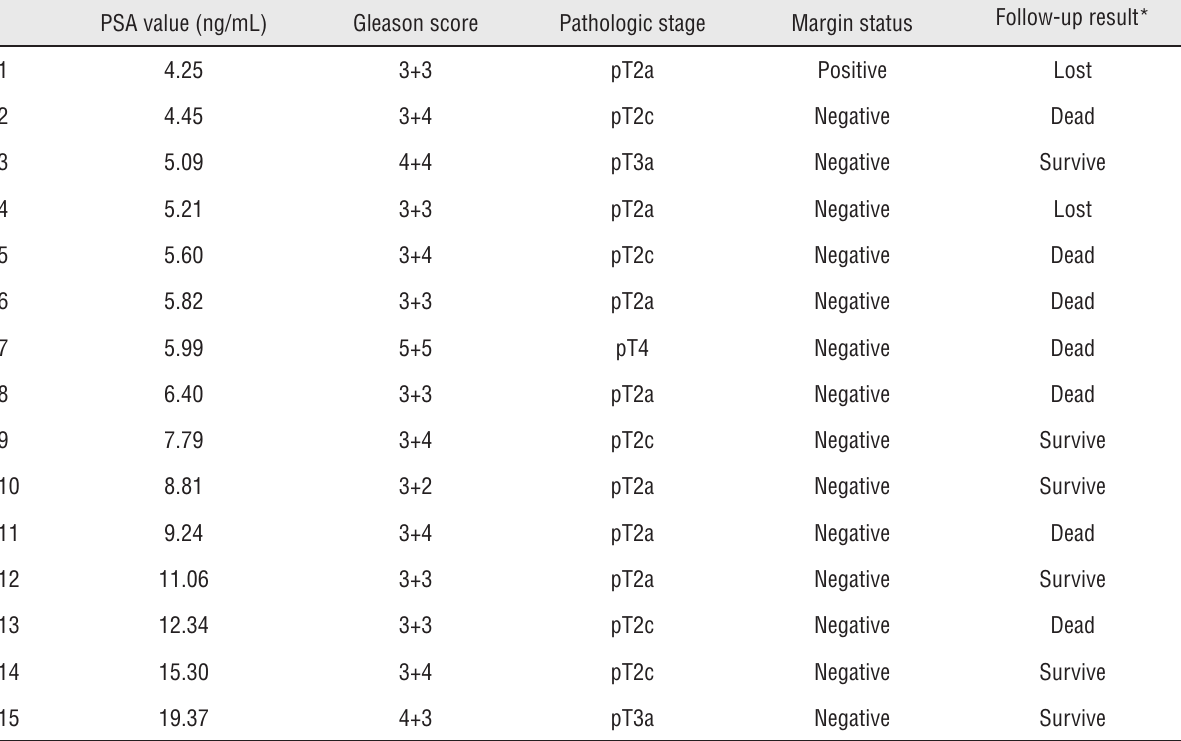
Table 3 - Detailed information on patients with a PSA value over 4ng/mL.